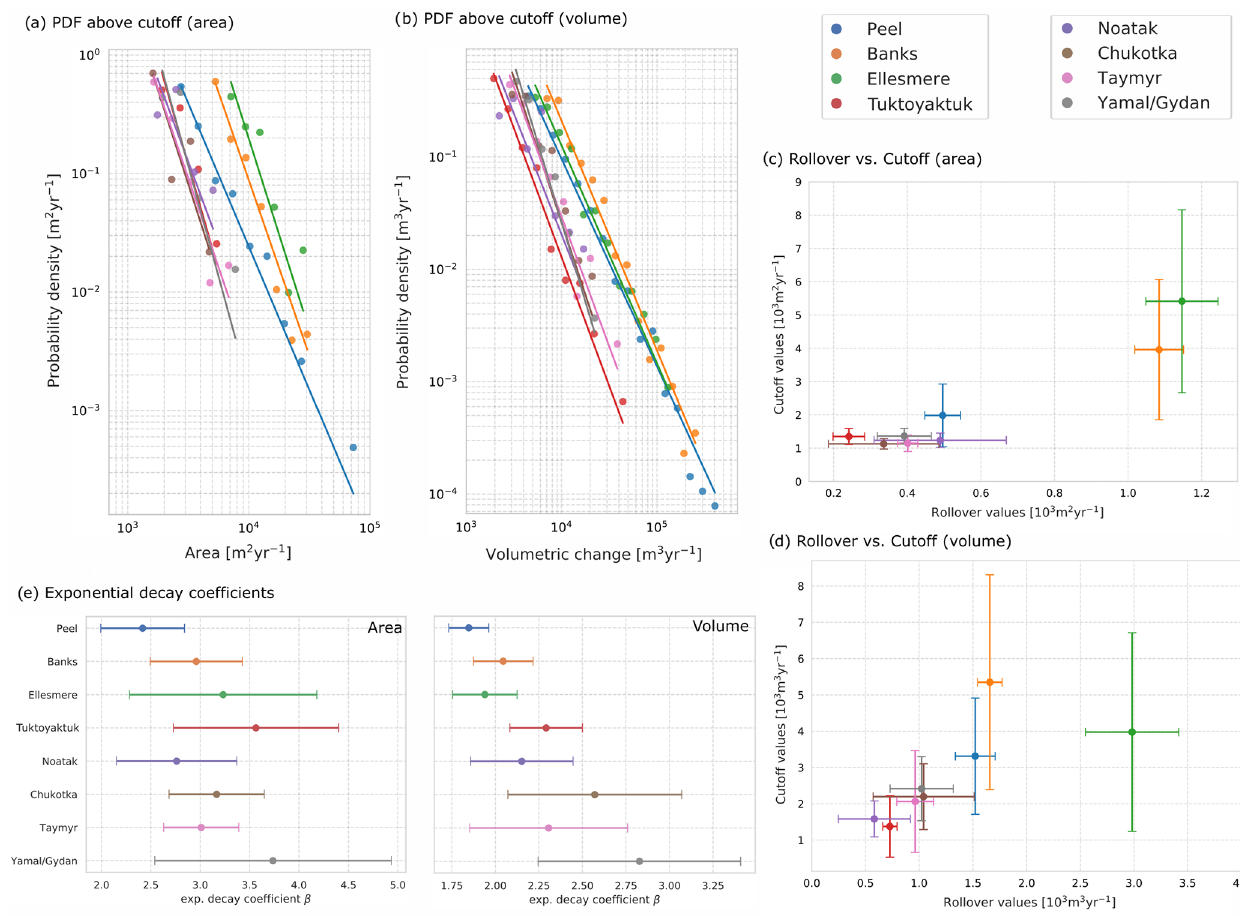
Figure 5. Cutoff, rollover, and exponential-decay coefficients. Panels (a) and (b) show the PDFs for yearly area and volumetric change rates, respectively, above the cutoff values. Panels (c) and (d) shows the respective estimated rollover and cutoff values for yearly area and volumetric change rates. (e) Exponential-decay coefficients for fits above the